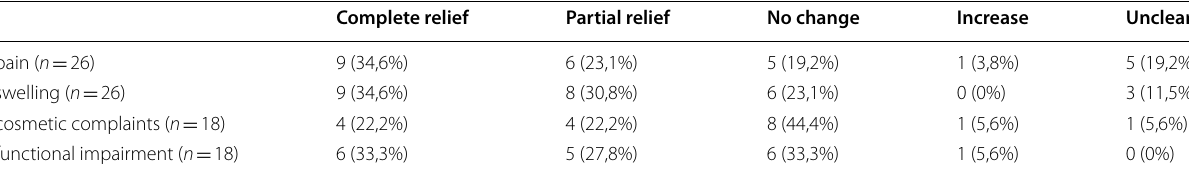
Table 8 Change in major symptoms after Sclerotherapy